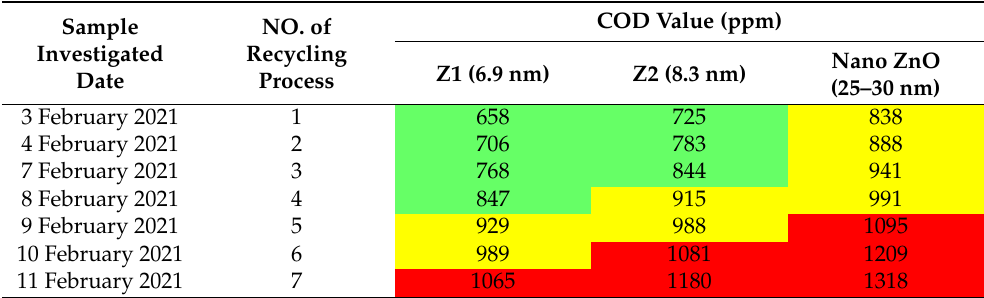
Table 2. COD values of real industrial wastewater by the recycling of different prepared ZQDs samples during photocatalysis by